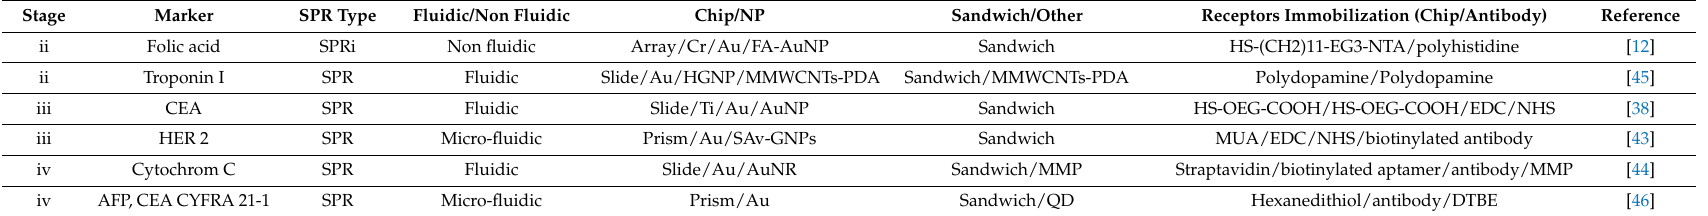
Table 4. Stages of biosensor development and technical solutions for biosensors with the use of